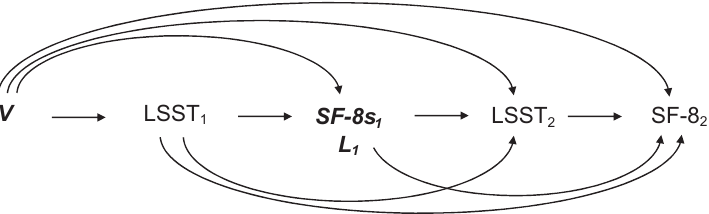
Figure 2. Causal diagram of the association of a time-varying Lack of Social Support and Trust (LSST) at the second / third trimester (LSST 1 ) and at 2.5 years postpartum (LSST 2 ) with the SF-8 score at 2.5 years postpartum (SF-8 2 ). LSST =